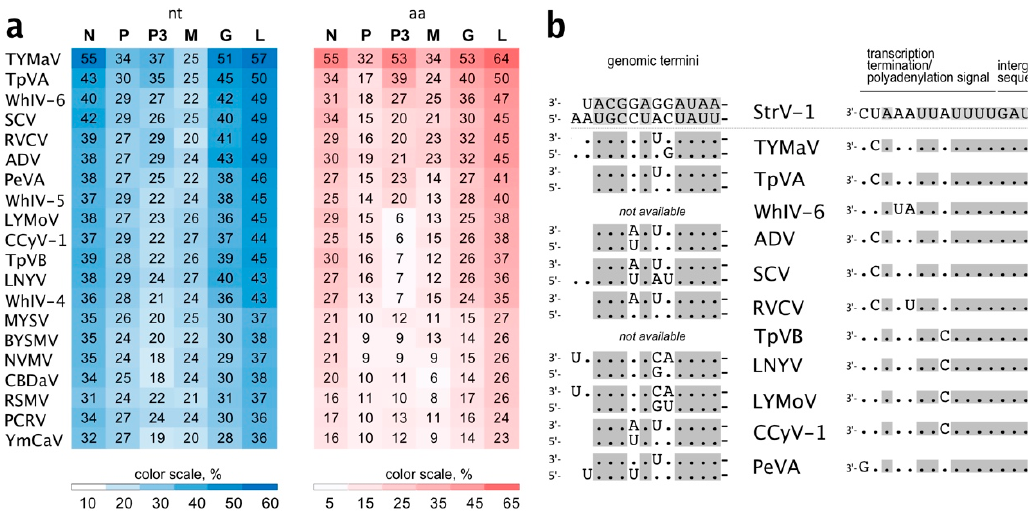
Figure 5. ( a ) Sequence nt and amino acid (aa) identities between genes of StrV-1- ˇCRM1 (B) and other cytorhabdoviruses; ( b ) Alignment of genomic termini and regulatory sequences of StrV-1- ˇCRM1 and related cytorhabdoviruses. The accession numbers are the same as those shown in Figure 3.